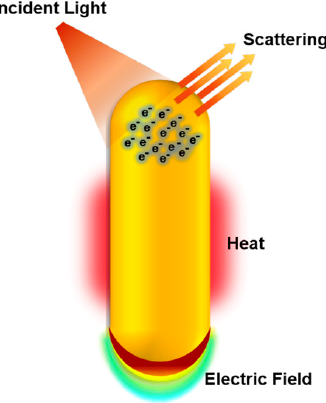
Figure 2. Physicochemical properties of gold nanoparticles explored in biological applications. Under illumination at or near the plasmon bands, gold nanoparticles absorb and scatter light, produce local electric fields, and can generate heat. These properties enable gold nanoparticles to be applied in bioimaging, surface-enhanced spectroscopies for sensing and molecular diagnostics, and photothermal therapy to destroy nearby cells. Due to their easy surface functionalization, gold nanoparticles are also explored for gene and drug delivery (reproduced with permission from Murphy et al., ref. [33]. Copyright 2019, American Chemical